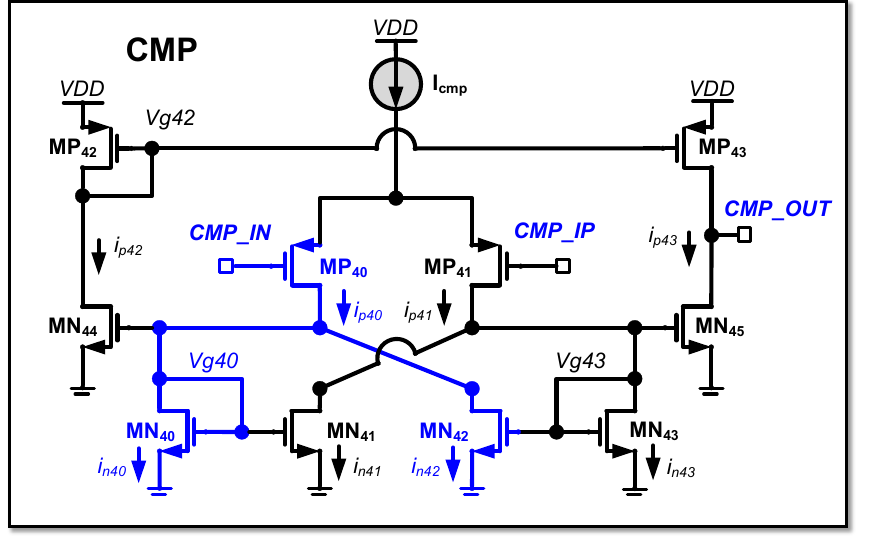
Figure 10. Detailed circuit diagram of the comparator (CMP).